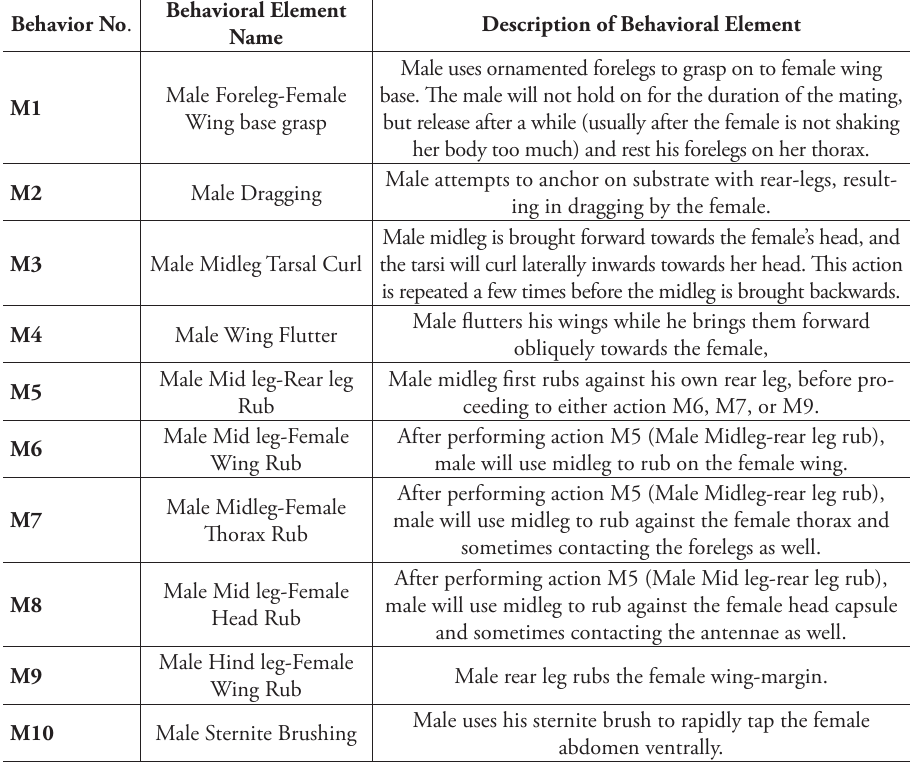
Table 4. Detailed descriptions of observed male behavioral elements during mating. Behavior No